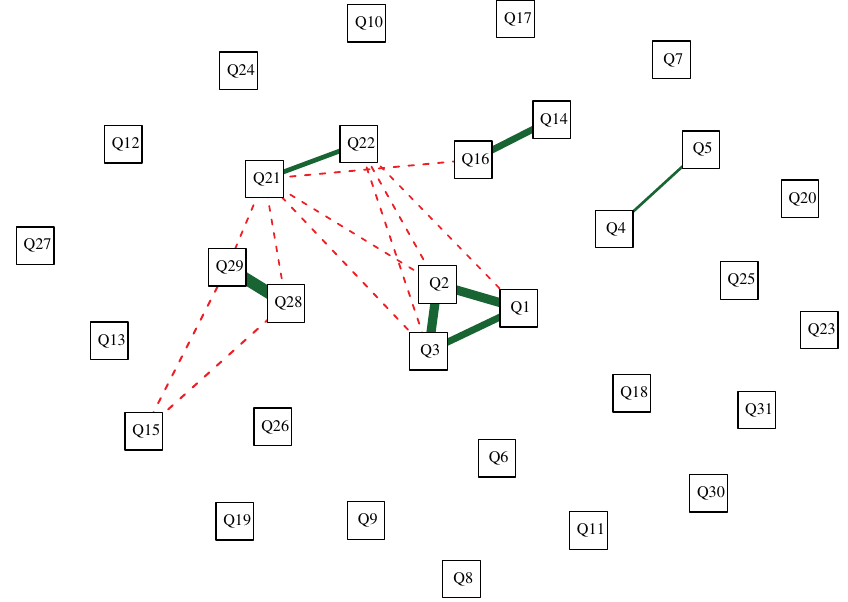
FIG. 3. Partial correlation matrix. Solid (green) lines represent positive correlations; dashed (red) lines negative correlations. Thicker lines represent larger correlations. phrase level. Sentences and phrases representing the same